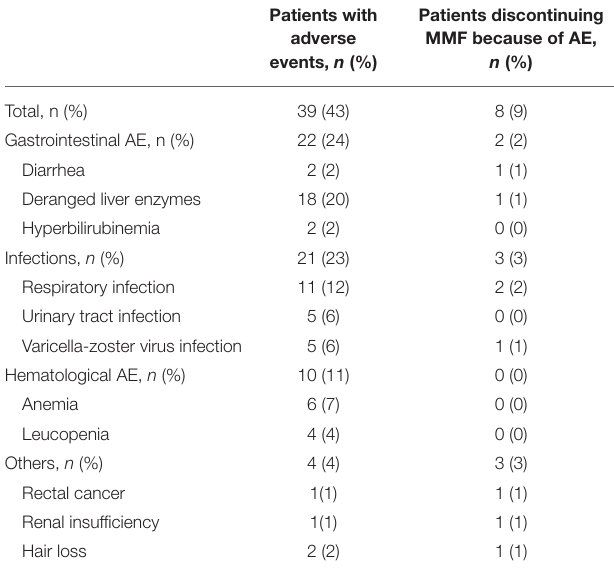
TABLE 2 | Adverse events after MMF treatment in 90 NMOSD patients.